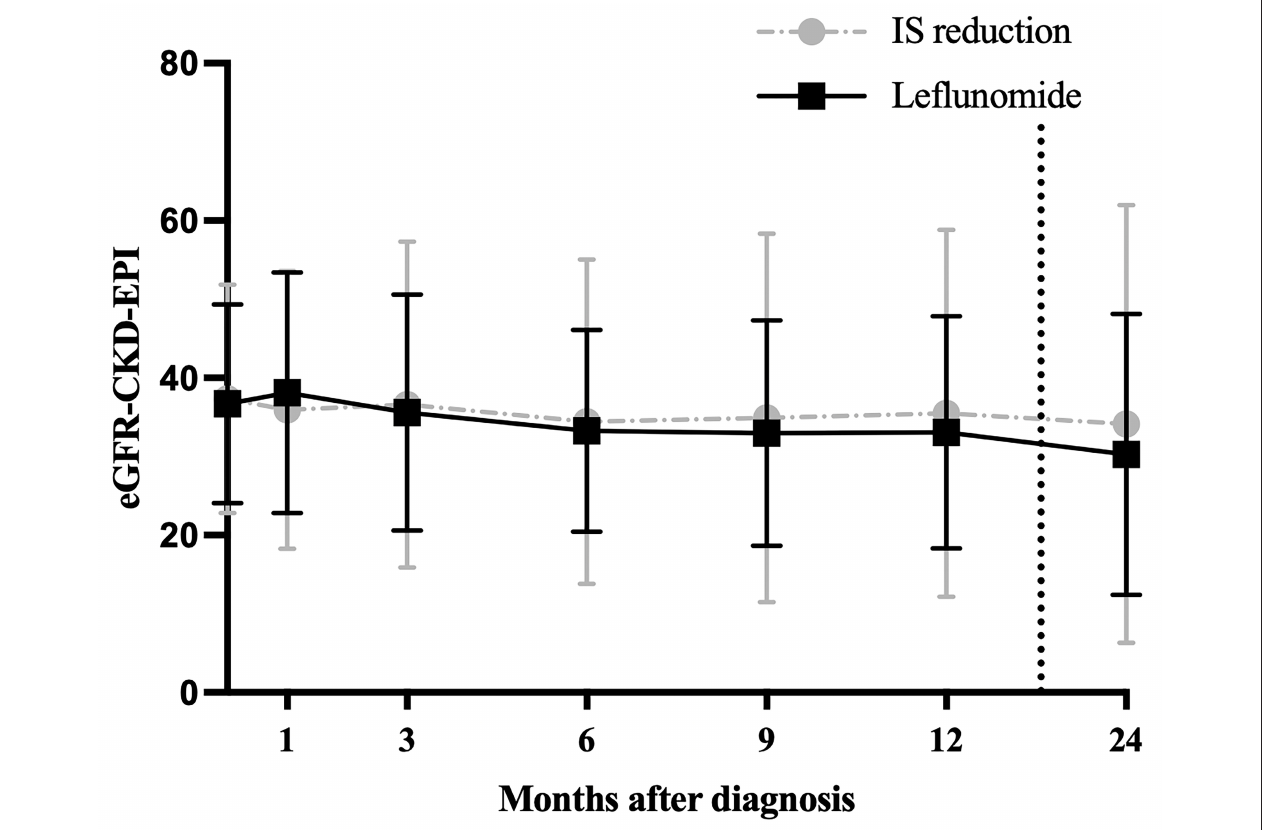
FIGURE 2 | Graft function in the 24 months after biopsy; shows the eGFR in ml/min/1.73 m 2 measured by the CKD-EPI equation between two major therapy groups. IS: immunosuppression reduction vs. Leflunomide. Dotted line between months 12 and 24 was used for visualization